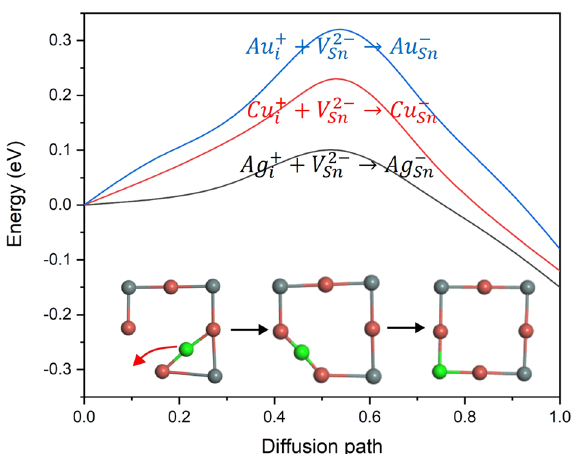
Fig. 6 Schematic of interstitials fi lling Sn vacancies. The energy pro fi le of the interstitial metal ion ( M = Au , Ag , and Cu ) migration to the neighboring Sn vacancy. The inset is the schematic of the process, where the green spheres are depicted for metal elements ( Au, Ag, Cu ), the red ones for Br , and the gray ones for Sn .